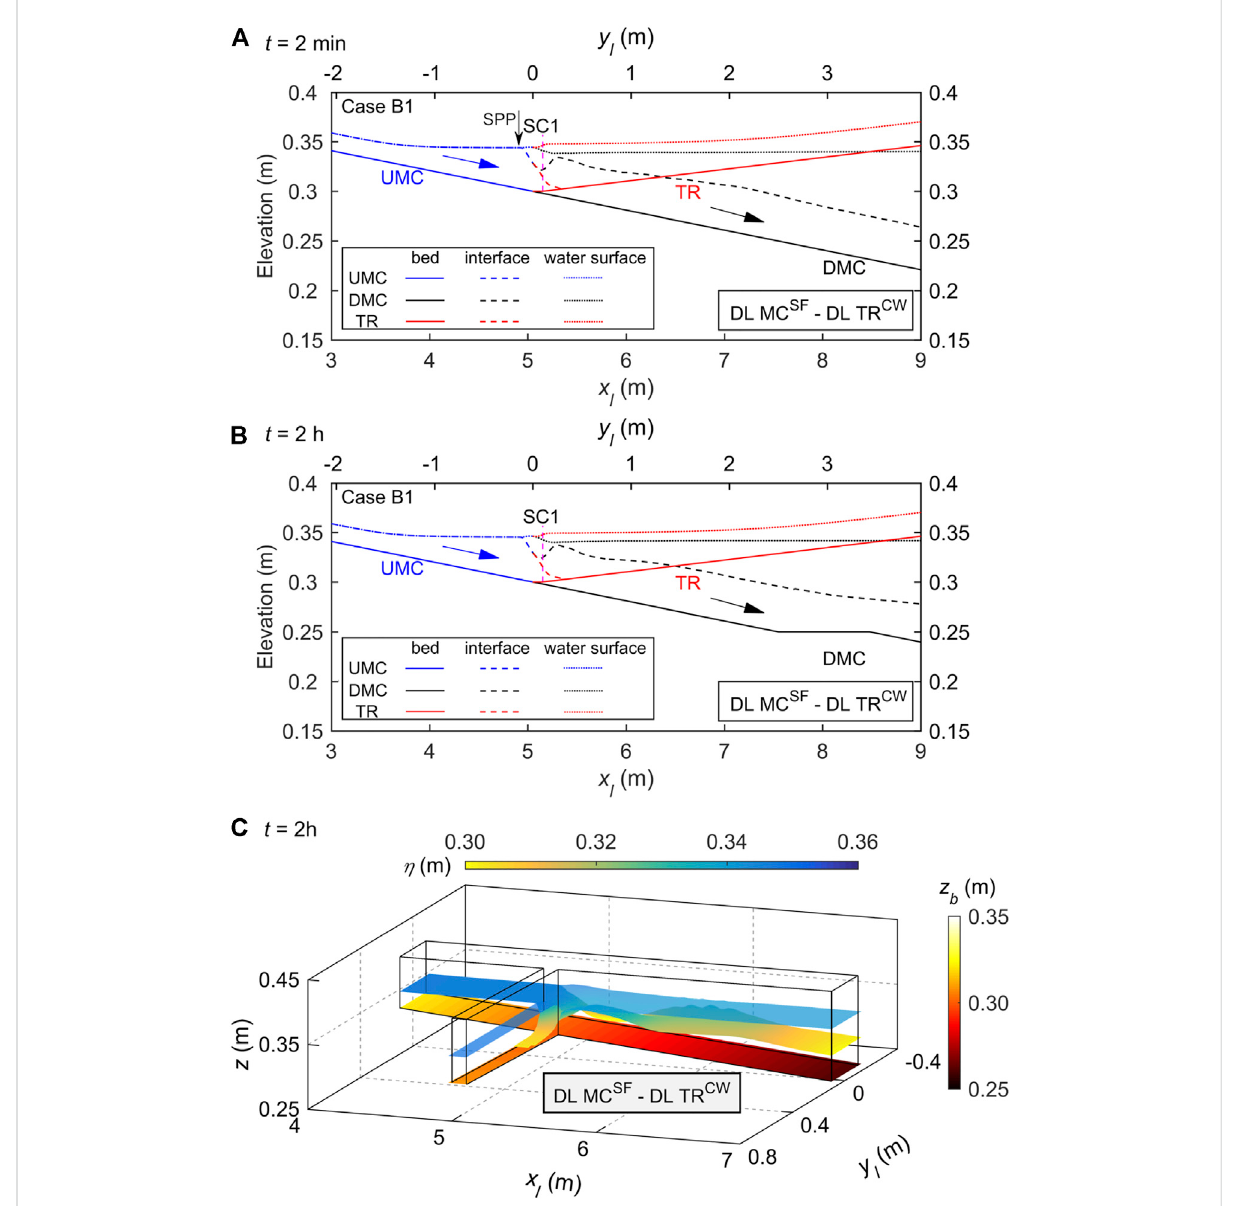
at the interface between the upper clear-water fl ow layer and the lower sediment-laden fl ow layer are greater when the turbidity current propagates upstream in the main channel. Bed aggradation occurs at the con fl uence, with more sediment deposited upstream of the junction along the main channel (Figures